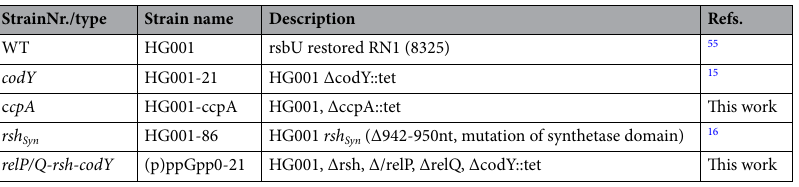
Table 1. Strains used in the